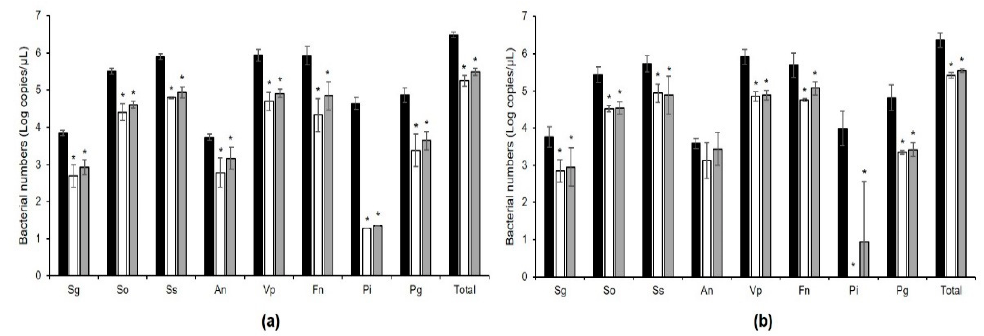
Figure 5. ( a – f ) Phase-contrast microscopic analysis and ( g , h ) absorbance at 600 nm of the inhibitory effects of W. cibaria CMU and CMS1 on the formation of multi-species implant biofilms using ( a – g ) titanium discs with machined or ( d – h ) SLA surface. ( a , d ) Control; ( b , e ) W. cibaria CMU-treated; ( c , f ) W. cibaria CMS1-treated. Magnification, 4000×. ( g ) Relative quantity of biofilms on titanium discs with machined surface; ( h ) relative quantity of biofilms on titanium discs with SLA surface. Black bar, control; white bar, W. cibaria CMU-treated; grey bar, W. cibaria CMS1-treated. Significant differences as compared to control determined as * p < 0.05.